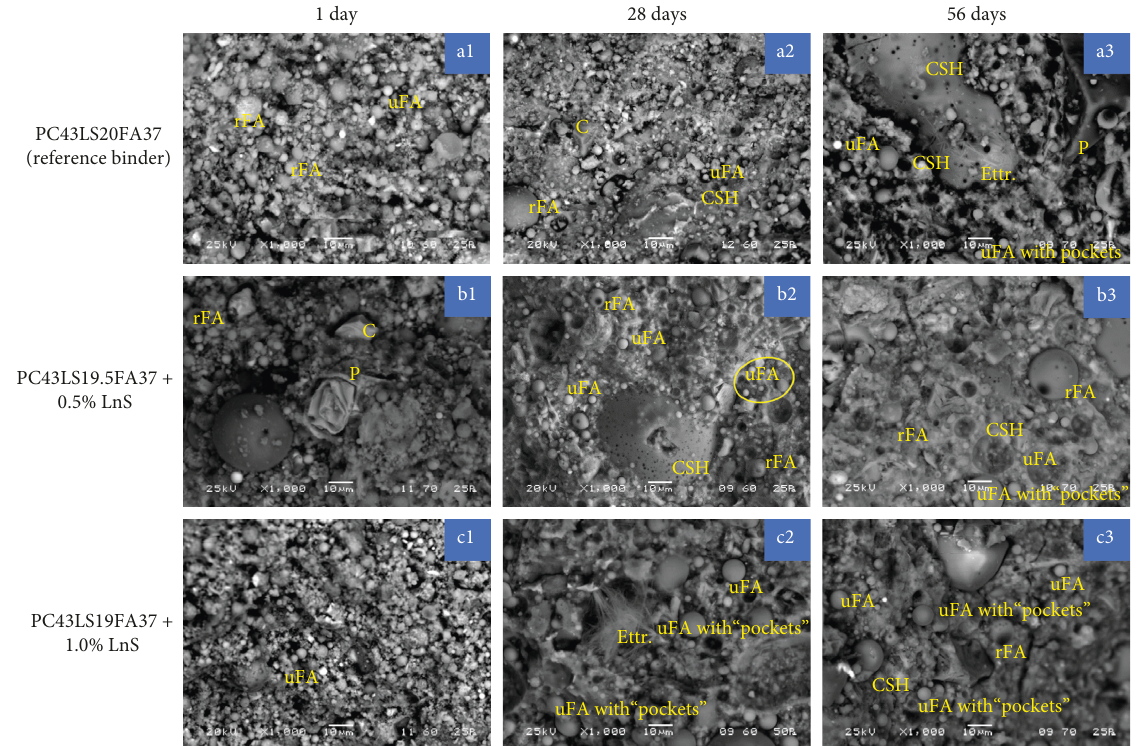
Figure 19: BSC micrograph of PC43LS20FA37 at low magnification at (a1) 1 day, (a2) 28days, and (a3) 56days; PC43LS19.5FA37+0.5% LnS at (b1) 1day, (b2) 28days, and (b3) 56days; and PC43LS19FA37+1% LnS at (c1) 1day, (c2) 28days, and (c3)